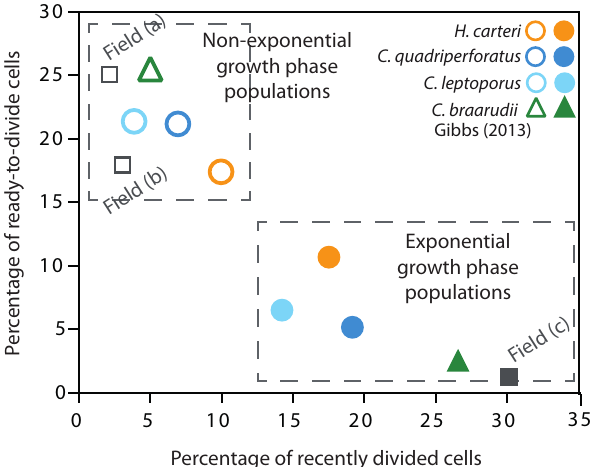
Figure 6. Contrasting exponential and non-exponential-phase cul- ture populations based on the percentage of recently divided and ready-to-divide cells within the population, as characterised by C N thresholds specific to each species (Fig. 3; Table 1). Mean percent- ages for exponential days are shown as filled data points, and the mean non-exponential experiment day percentages are shown as unfilled data points. Also indicated (grey squares) are the charac- teristic percentages of three Coccolithus field population data sets presented in Gibbs et al. (2013) – Field (a) is Scotland, Field (b) is Iceland non-bloom (both experiencing slowed growth) and Field (c) is Iceland bloom experiencing rapid